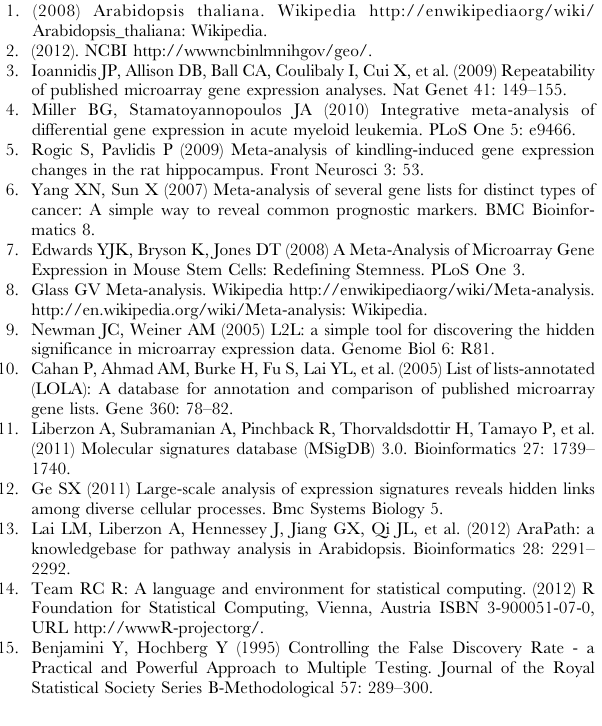
Fig. S5. The sub-network 5 corresponding to Cluster 5. Fig. S6. The sub-network 6 corresponding to Cluster 6. Fig. S7. The sub- network 7 corresponding to Cluster 7. Fig. S8. The sub-network 8 corresponding to Cluster 8. Fig. S9. The sub-network 9 corresponding to Cluster 9. Table S1. Results of sub-network 1 corresponding to cluster 1. Table S2. Results of sub-network 2 corresponding to cluster 2. Table S3. Results of sub-network 3 corresponding to cluster 3. Table S4. Results of sub-network 4